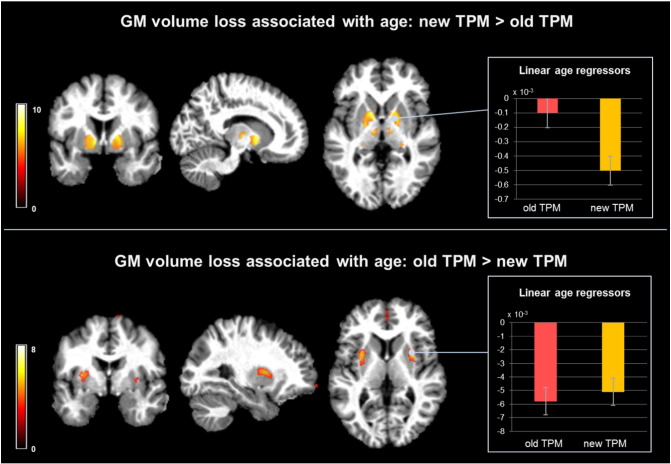
Interaction between age-related gray matter (GM) volume loss and tissue probability maps (TPM) used for GM volume estimation from T1-weighted data. Top panel: statistical parametric maps of stronger negative correlation between age and GM volume estimates from new TPM compared to old TPM. Bar plot—mean linear regressors for age effects on volume in the pallidum. Bottom panel: statistical parametric maps of stronger negative correlation between age and GM volume estimates from old TPM compared to the new TPM. Bar plot—mean linear regressors for age effects on volume in the putamen.